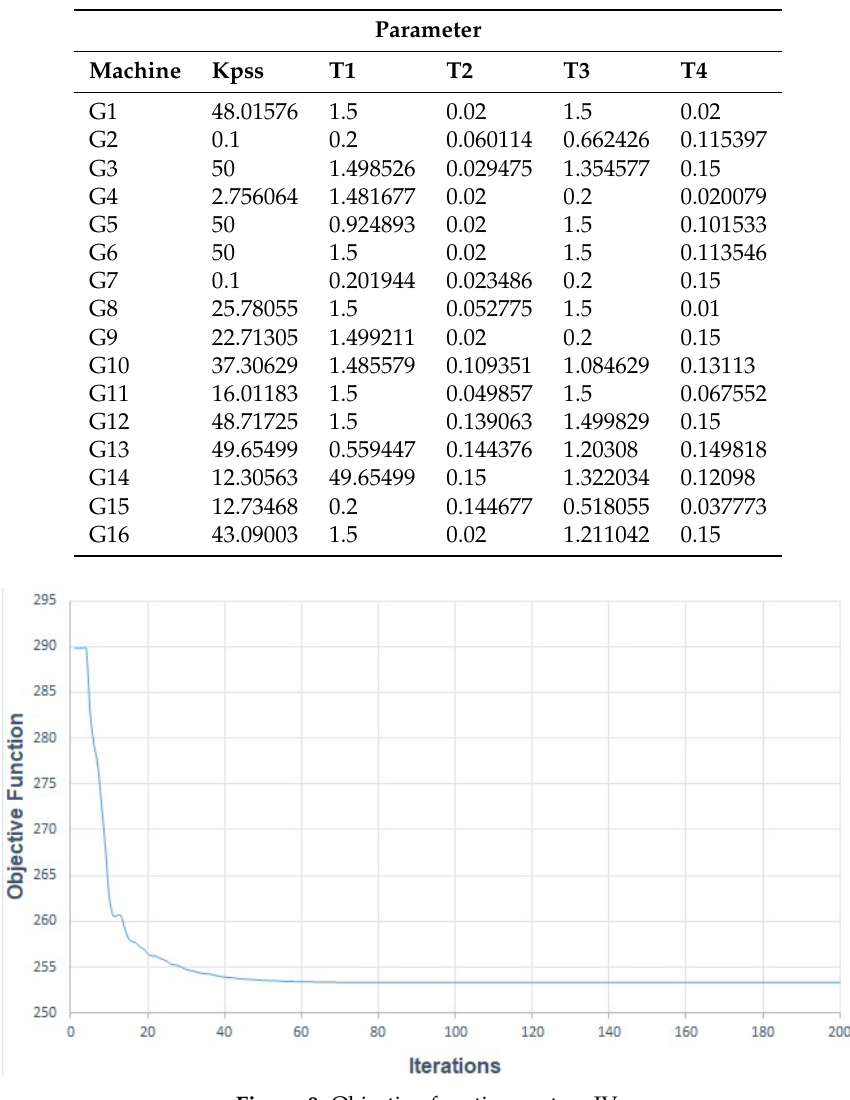
Table 8. Optimal parameters for system IV.